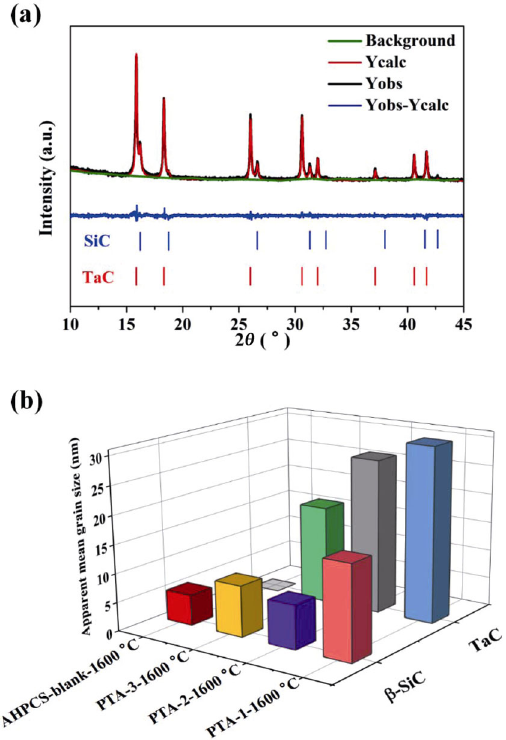
Fig. 5 (a) Diffraction patterns of the ceramics annealed at 1600 ℃ with the result of Rietveld refinement. Yobs and Ycalc represent the observed and calculated profiles, respectively; the green line represents the background; the blue line at the bottom denotes the intensity difference between the observed and calculated profiles. (b) Estimated grain size of β-SiC and TaC by Rietveld